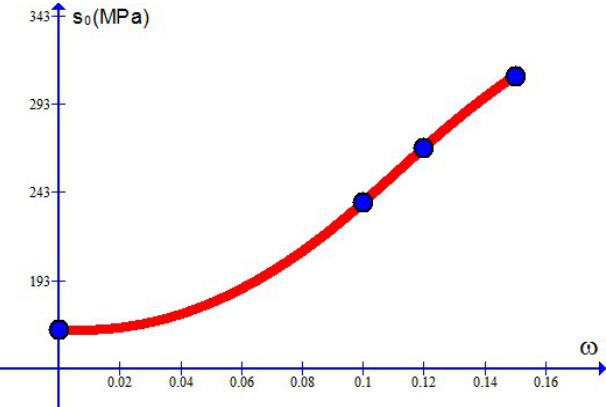
Figure 13. The plateau stress s 0 changing with the weight percentage ω (dots for simulation results).